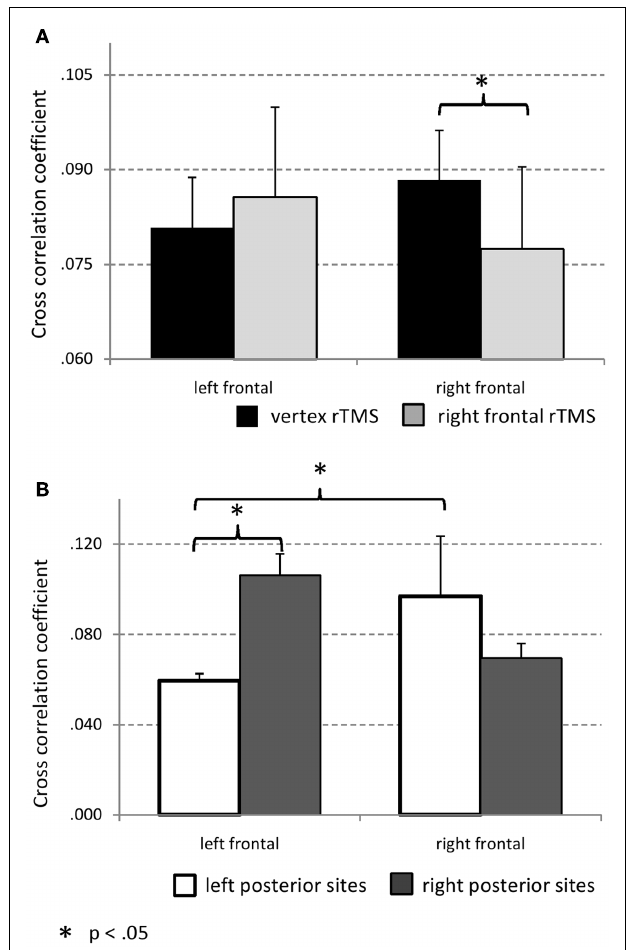
FIGURE 4 | (A) Maximal cross-correlation coefficient as a function of hemisphere and stimulation condition. Averaged maxima of cross-correlation coefficient between recording site FC4 and all posterior electrodes of interest as well as FC3 and posterior recording sites are shown. After rTMS to the right FEF attenuated cross-correlation coefficients between FC4 (overlying the stimulation site) and posterior sites is obtained. (B) Hemispheric differences of cross-correlation strength between frontal and posterior sites. Note that in contrast to FC3 there is no significant difference found for coupling between right frontal and either left or right posterior sites.This suggests the right FEF to top-down control bilateral visual